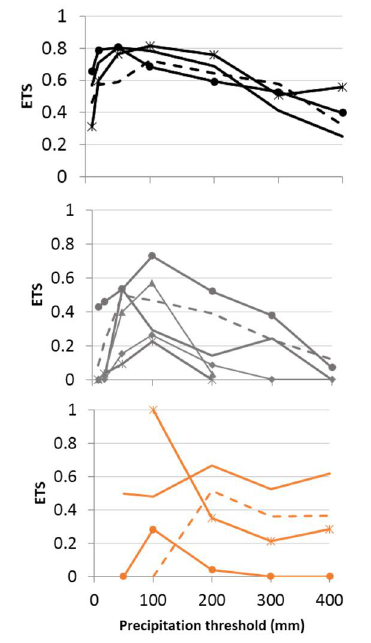
Figure 5. ETS for precipitation thresholds of 10, 20, 50, 100, 200, 300 and 400 mm on the Coastal plains (black), Andean highlands (grey) and Amazonian rainforest (orange)